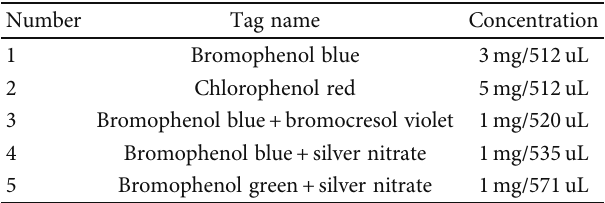
Table 2: Array reactants in colorimetric sensors.